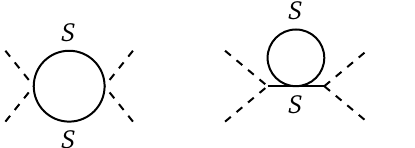
( 1 ) . Left: Diagram yielding a κ 2 - φ ,2 / M 2 -contribution. The dashed line S